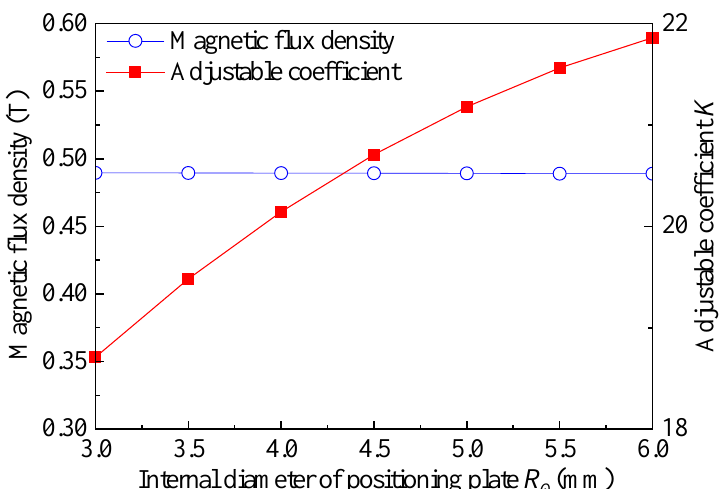
Figure 15. Magnetic flux density and adjustable coefficient under different inner diameter of posi- tioning plate.